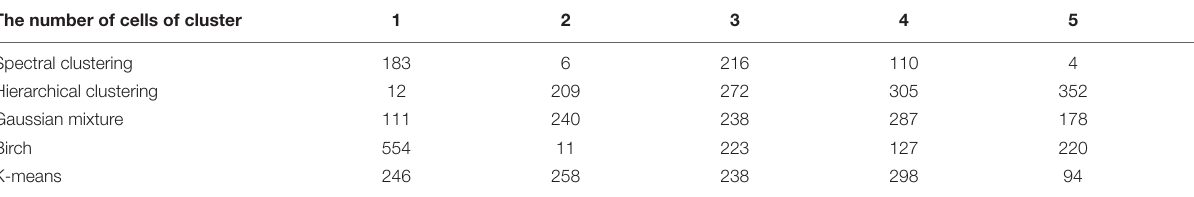
TABLE 1 | The number of cells in each cluster by different algorithms.